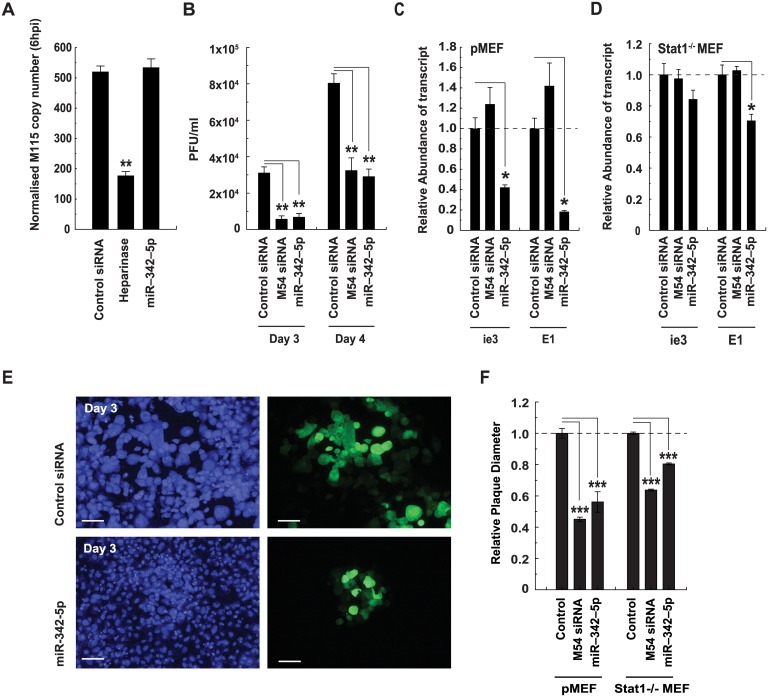
MiR-342-5p inhibits infectious virus production and spread.(A) MiR-342-5p does not affect MCMV entry. MCMV M115 DNA copy number in pMEF transfected with negative control siRNA or miR-342-5p (25 nM) for 48 h and then infected with MCMV (MOI = 0.1) for 4 h. Data are mean +/− SEM (n = 3). **p ≤ 0.01. (B) MiR-342-5p inhibits infectious MCMV production. PMEF were transfected (25 nM, 48 h) with nontargeting control siRNA, MCMV M54 siRNA, or miR-342-5p and then infected with MCMV (MOI = 0.0025). PFU in supernatants were then quantitated by plaque assay at 3 dpi and 4 dpi. Data are mean +/− SEM (n = 3). **p ≤ 0.01. (C and D) MiR-342-5p inhibits MCMV gene expression. Primary MEF (C) or STAT1-/- MEF (D) were transfected (25 nM, 48 h) with nontargeting control siRNA, MCMV M54 siRNA, or miR-342-5p and then infected with MCMV (MOI = 0.01). MCMV transcript abundance was then quantitated by Q-RT-PCR at 6 hpi. Data are mean +/− SEM (WT, n = 3, STAT1-/-
n = 4). *p ≤ 0.05. (E) Images showing effects of miR-342-5p on MCMV-GFP infected cells at 3 dpi. Bar = 100 μm. (F) MiR-342-5p effects on plaque formation were analysed at 4 dpi when monolayers were fixed and plaque diameter quantitated using ImageJ software. Data are mean +/− SEM, n = 4. For pMEF: Control = 168 plaques counted, M54s siRNA 66 plaques counted, miR-342-5p n = 23. STAT1-/- MEF: Control = 1,091 plaques counted, M54 siRNA = 822 plaques counted, miR-342-5p = 1,011 plaques counted. ***p ≤ 0.001